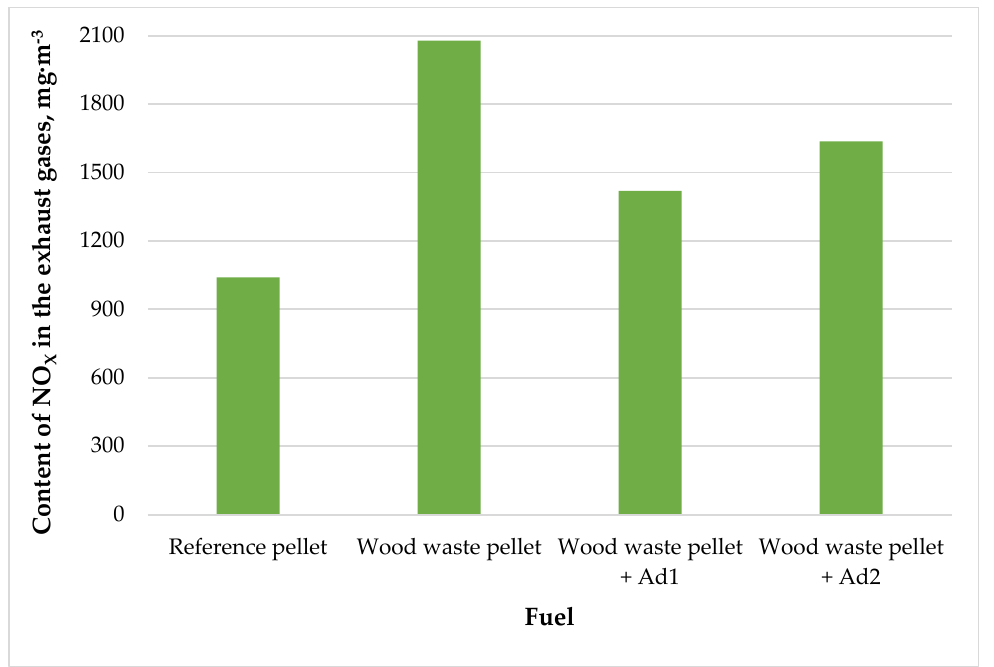
Figure 9. Nitrogen oxide content in the exhaust gases during the combustion of fuels.